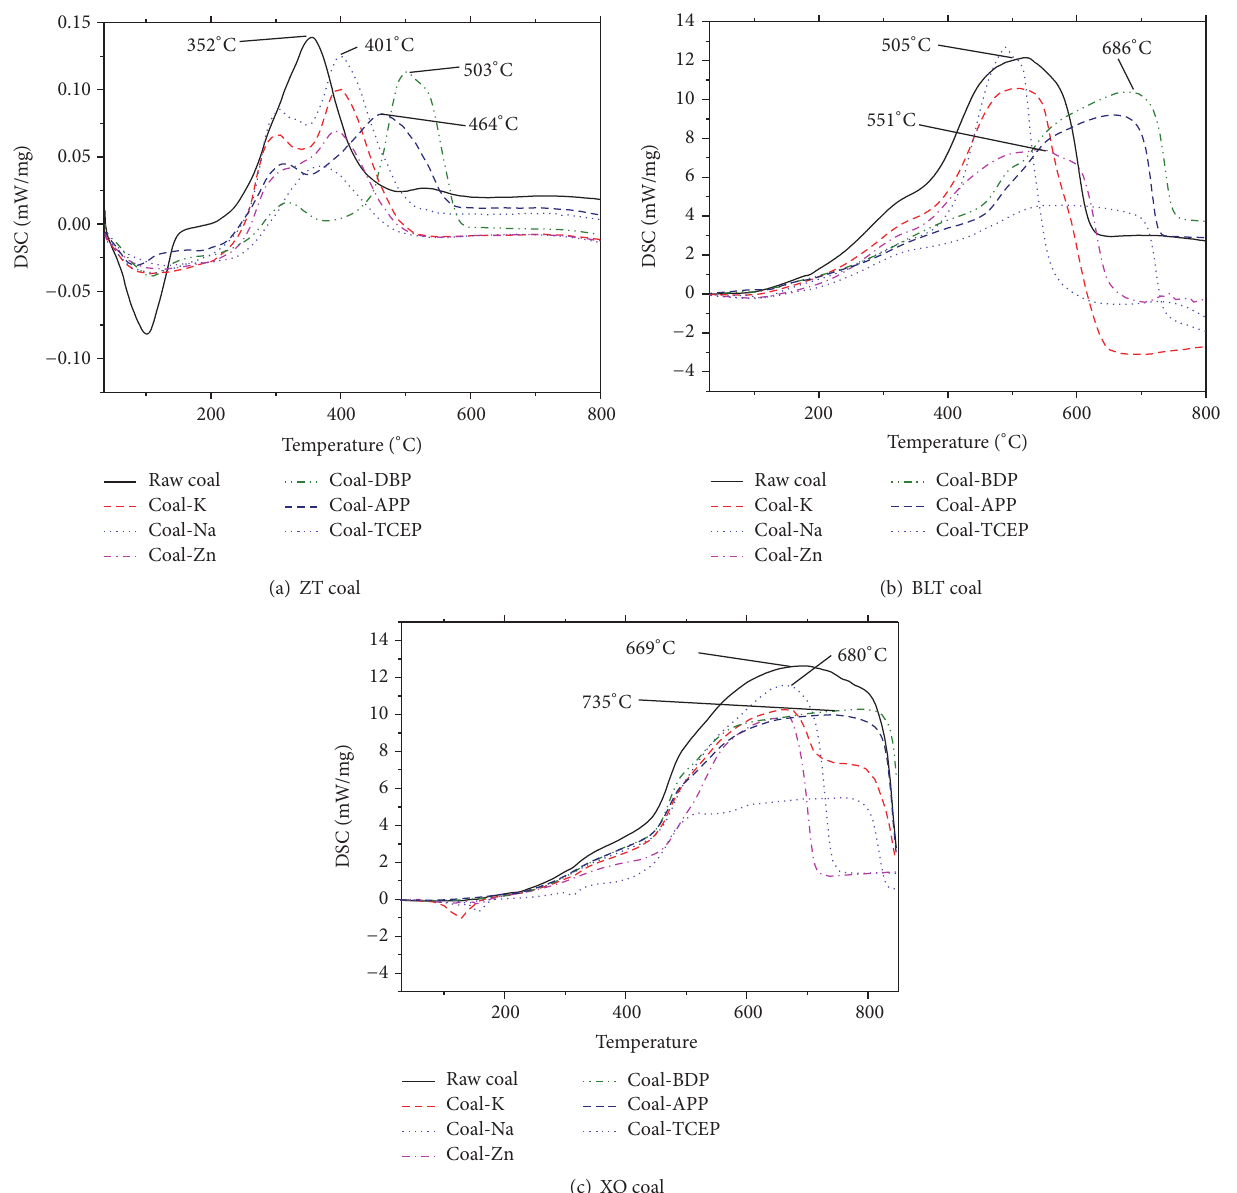
Figure 4: The DSC curves of coal samples before and after